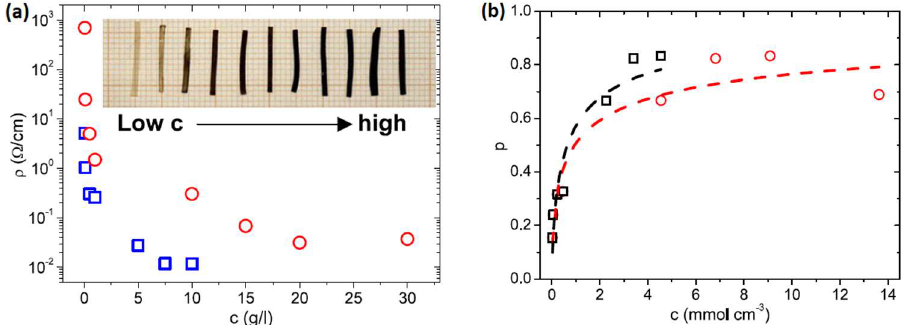
Figure 1. Liquid single-crystal elastomer (LSCE) reprocessed with carbon nanoparticles. ( a ) Effective resistivity ( ρ ) of the macroscopic LSCE as a function of concentration (c) for carbon black (blue squares) and carbon nanohorn (red circles) particles of a reprocessed side-chain siloxane-based LSCE film. Top: picture of carbon-black-reprocessed LSCE samples. ( b ) Particle fraction (p) versus concentration (c) for carbon black (black squares) and carbon nanohorns (red circles). The best-fit lines of the Langmuir equation are also shown [50]. Adapted with permission from the authors of [37]. © IOP Publishing. Reproduced with permission. All rights reserved.